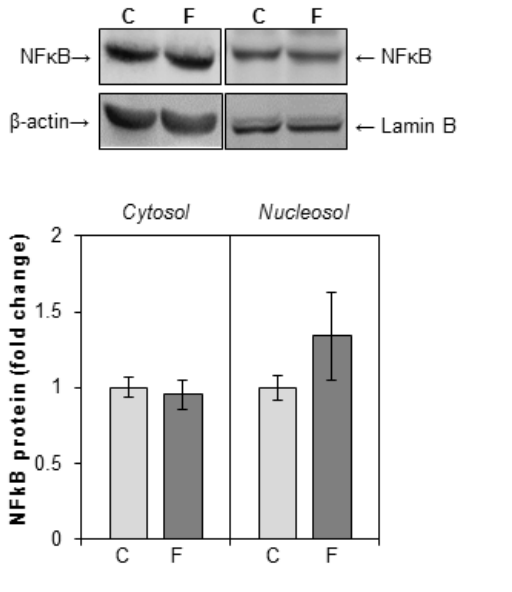
Table 1. Antioxidant enzyme activities and the level of glutathione (GSH), total thiols (SH), and thiobarbituric acid reactive substances (TBARS) in the liver of female rats subjected to a fructose-rich diet over a period from weaning to adulthood. SOD1, cytoplasmic copper-zinc superoxide dismutase; SOD2, mitochondrial manganese superoxide dismutase: CAT, catalase; GSH-Px,